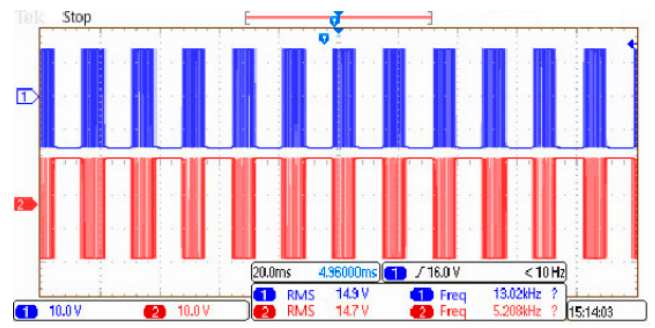
Figure 19. Drive Figure 19. Drive signal.